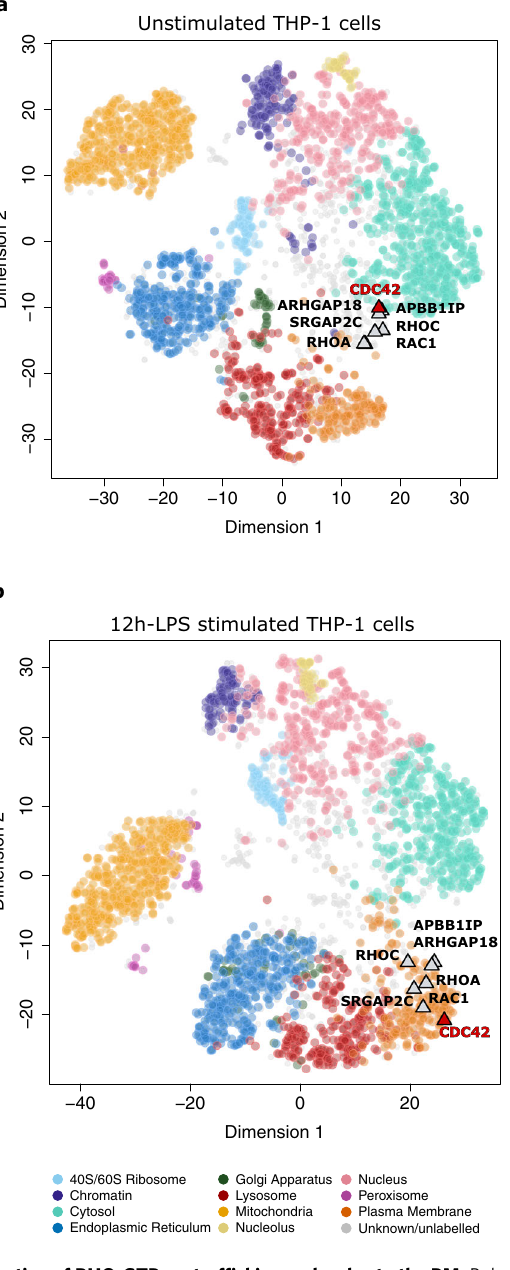
signi fi cantly enhanced after LPS stimulation 72 .